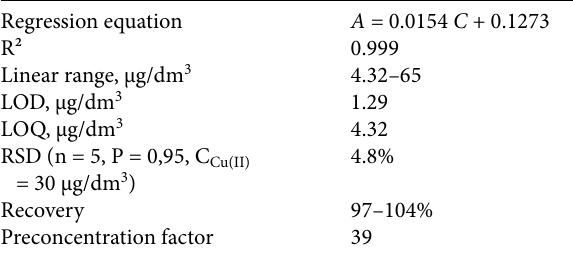
Table 1. Analytical figures of merit for Cu(II) determination by the developed DLLsME – UV/Vis spectrophotometry method Regression equation